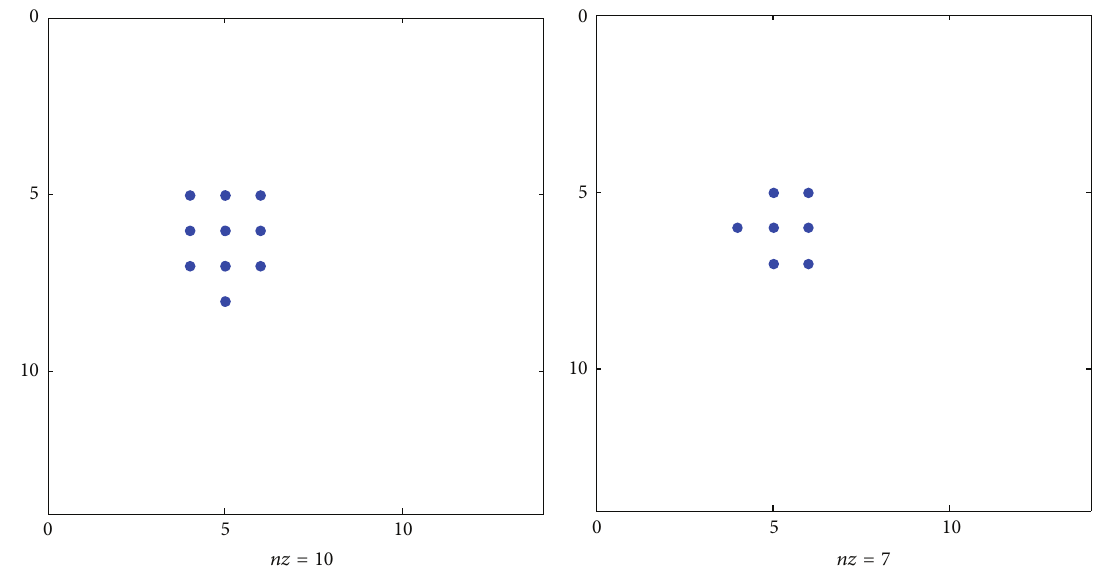
Figure 2: Extracted ECG two-lead signals